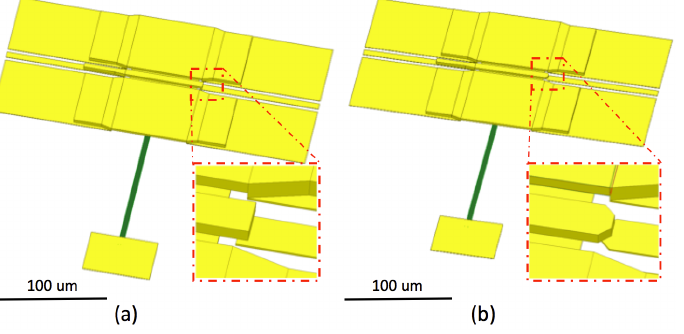
Figure 6. Three dimensional (3-D) model of high resistivity silicon-based MEMS switch. The initial design ( a ) has a larger parallel area at the actuator tip, which causes larger capacitance. To reduce such capacitance for higher isolation performance, its actuator tip is trimmed ( b ).